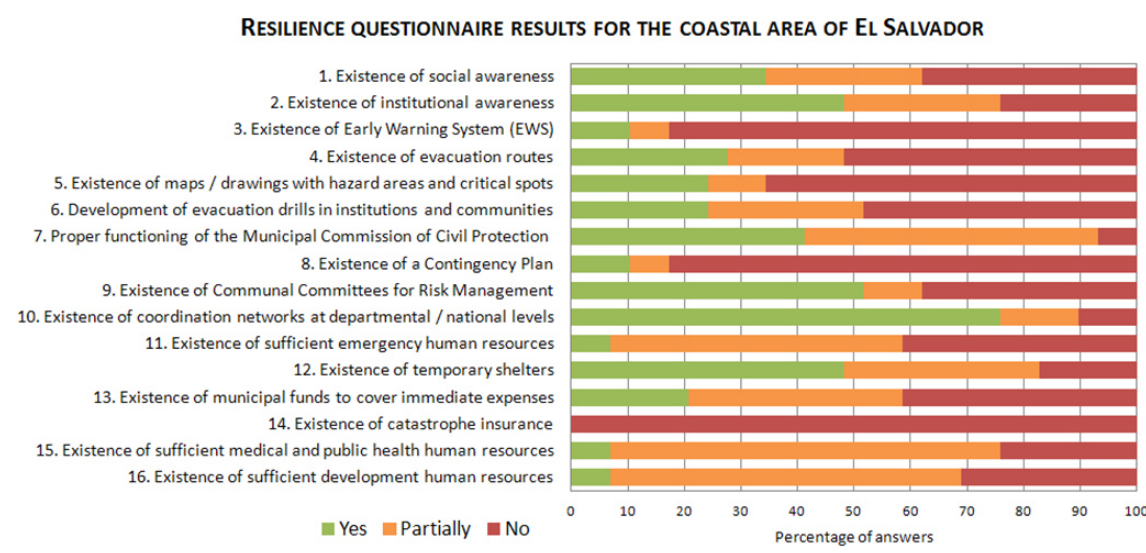
Figure 4. Resilience questionnaire results for tsunami hazard on the coastal area of El Salvador.